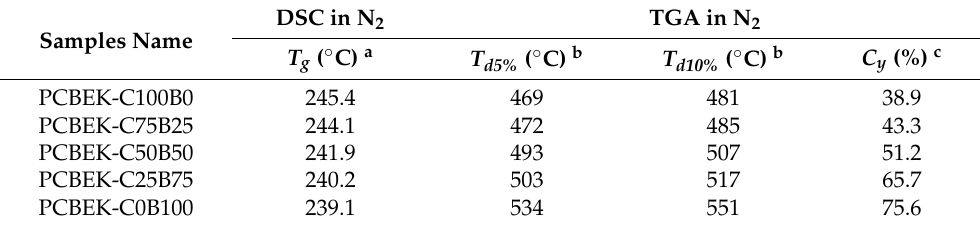
Figure 3. ( a ) DSC curves of PCBEKs series polymers and ( b ) comparison of theoretical values calculated using Fox equation. Table 2. Thermal performance parameters of copolymer